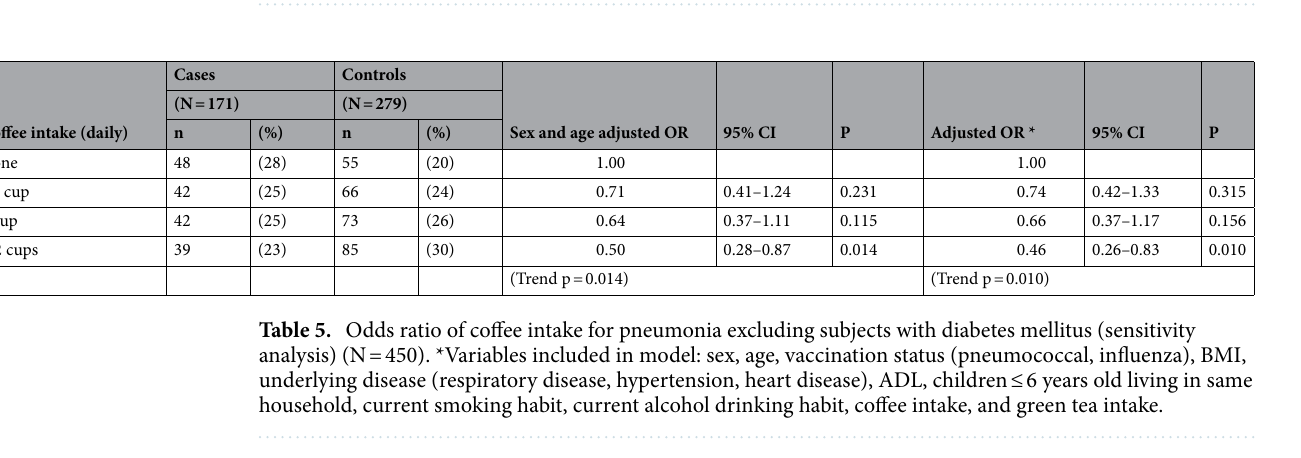
Table 4. Odds ratio of coffee intake for pneumonia in Sub analysis (2). *Variables included in model: same as Table 3.